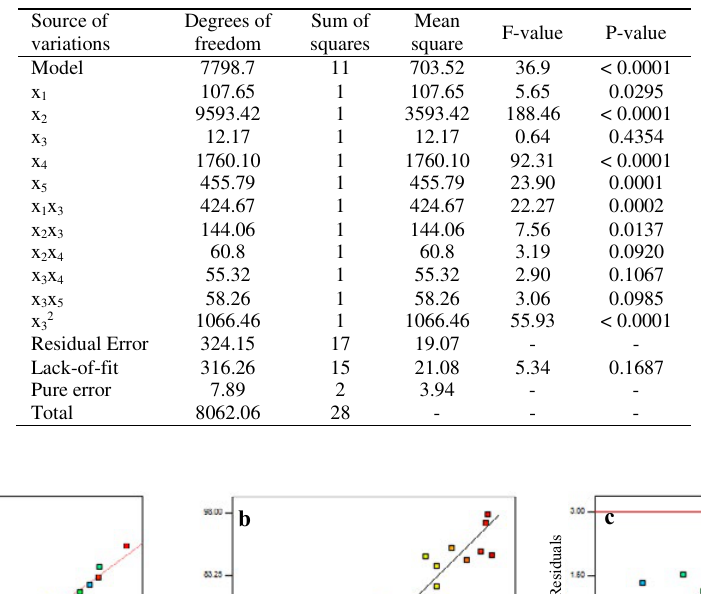
Table 6. ANOVA for the fit of the experimental data to the response surface model.